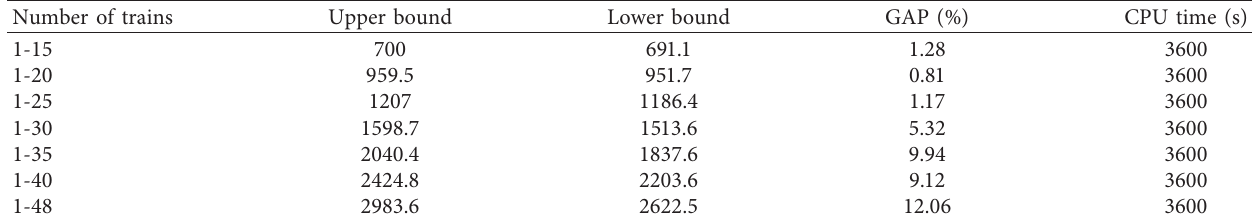
Table 9: Performance comparison with an increase in the number of trains for medium-sized cases. Number of trains Upper bound Lower bound GAP (%) CPU time